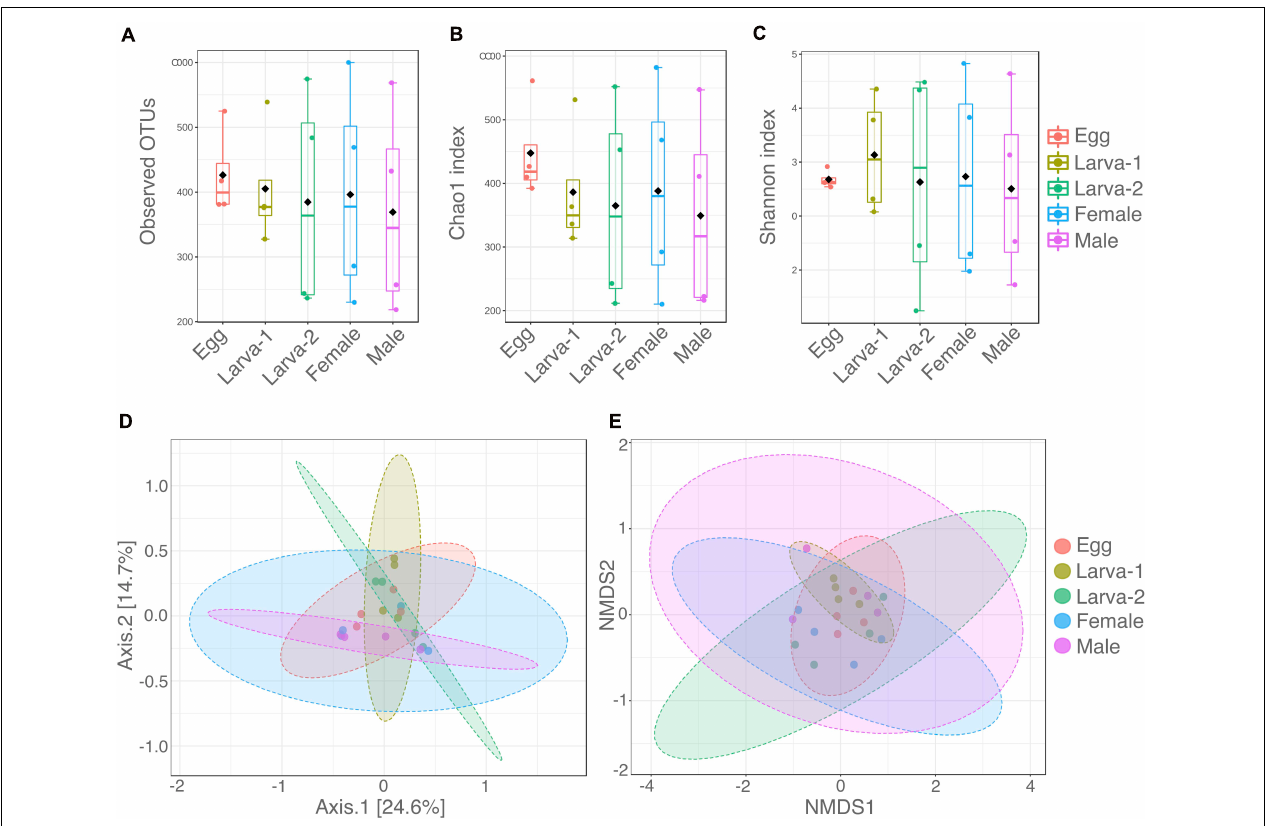
FIGURE 1 | Distribution of alpha and beta diversity of gut-associated microbiota across developmental stages of Hypothenemus hampei . Alpha diversity was analyzed with (A) the number of observed OTUs; (B) Chao1; and (C) Shannon H’ indexes from four biological replicates for life stage. Beta diversity was analyzed using (D) principal coordinates analysis (PCoA) and (E) non-metric multidimensional scaling (NMDS) based on a Bray-Curtis distance matrix depicting differences in the composition of gut microbiota. Dots in panels (D,E) represent each sample for the life stages. Alpha and beta diversity analysis were performed using MicrobiomeAnalyst